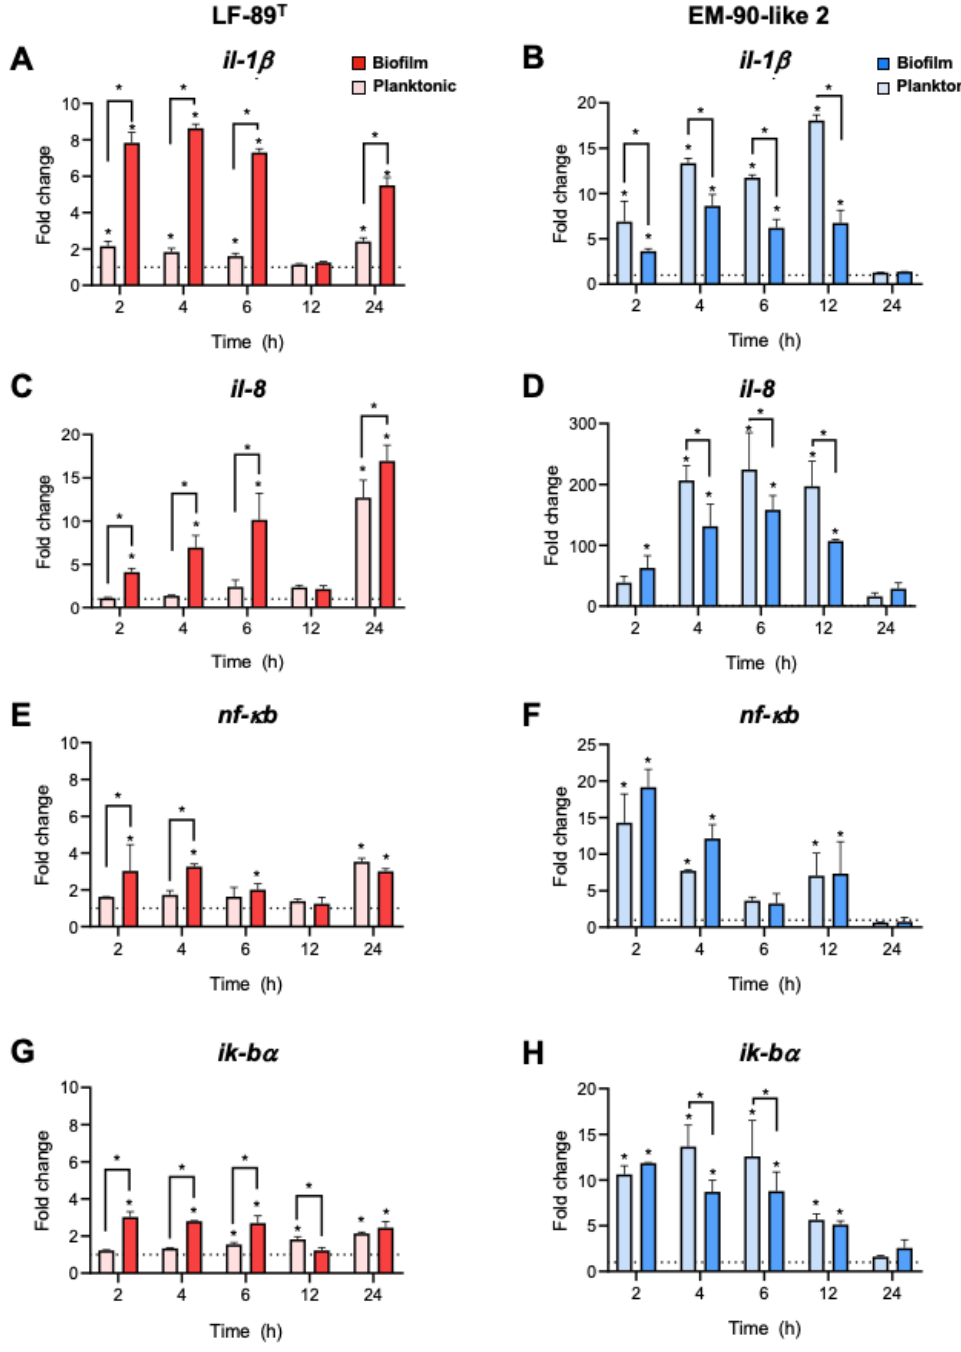
Figure 3. Analysis of the immune gene expression induced by planktonic and sessile P. salmonis . SHK-1 cells were infected with P. salmonis LF-89 T or EM-90-like 2 strain in planktonic or sessile conditions for 2, 4, 6, 12, and 24 h, and the mRNA levels of il-1 β ( A , B ), il-8 ( C , D ), nf- κ b ( E , F ), and i κ b- α ( G , H ) were analyzed by qRT-PCR. The expression of ef-1 α was used as a normalizer. The graph depicts the average ± standard deviation of the gene expression fold change. Control cells were used as a calibrator (dotted line). Asterisks above the bars indicate statistically significant di ff erences evaluated using Tukey’s multiple comparison test ( p <